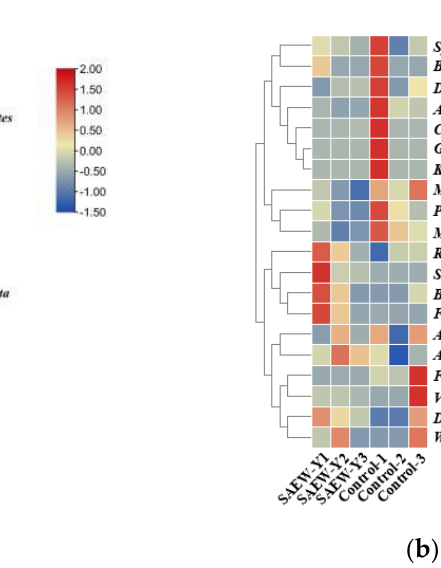
Figure 3. A hierarchically clustered heatmap of the microbial profiles of SAEW and control grains samples based on ( a ) Greengenes database and ( b ) UNITE database taxonomy assigned to genus levels. The relative abundance of the bacterial ( a ) and fungal ( b ) groups were log 2 transformed. The X -axis and the Y -axis represent sample name and the genus, separately. SAEW-Y1, SAEW-Y2, and SAEW-Y3 are the parallel treatment groups of SAEW, and the same for control.